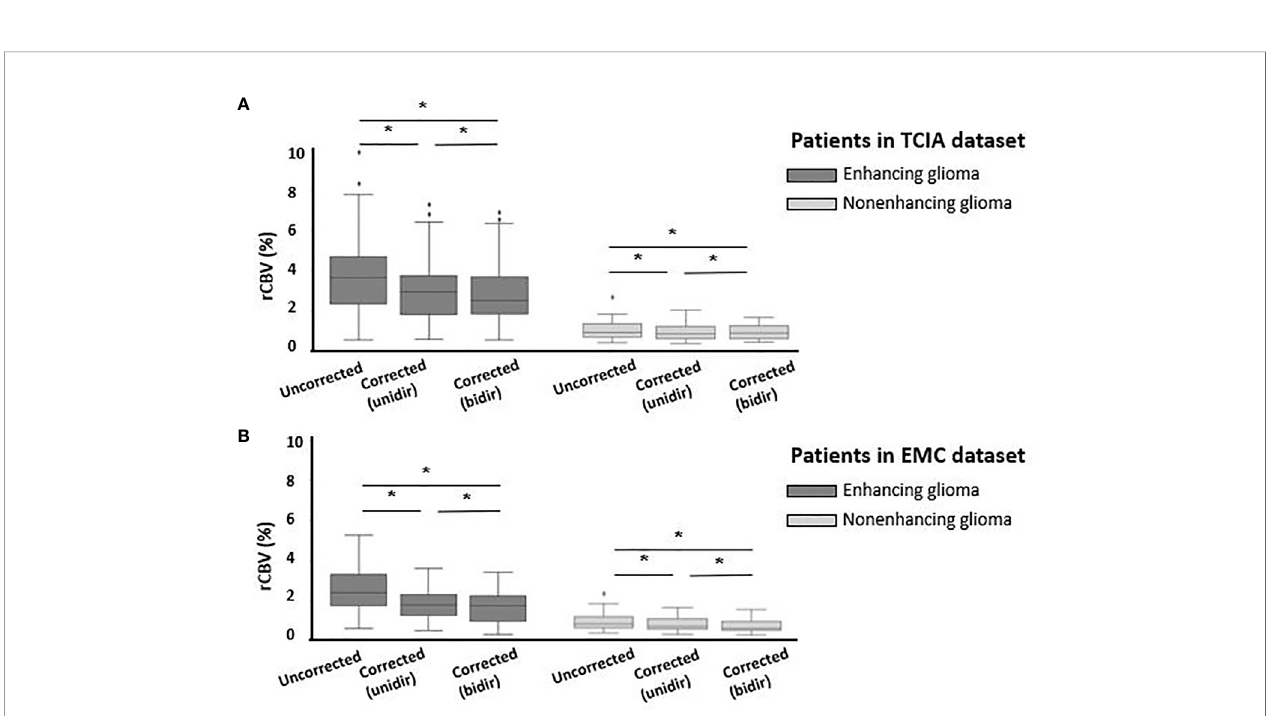
FIGURE 3 | Boxplots of uncorrected, unidirectional corrected and bidirectional corrected rCBV values from left to right (A) for enhancing glioma (n = 35) (dark gray) and for nonenhancing glioma (n = 14) (light gray) in TCIA dataset; (B) for enhancing glioma (n = 20) (dark gray) and nonenhancing glioma (n = 27) (light gray) in EMC dataset. *Signi fi cantly different, p < 0.05.